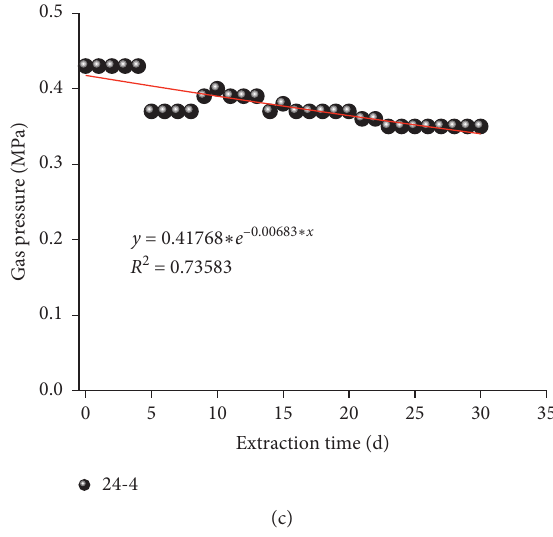
Figure 9: Pressure attenuation of test holes 2–4# in No. 24 drilling field.